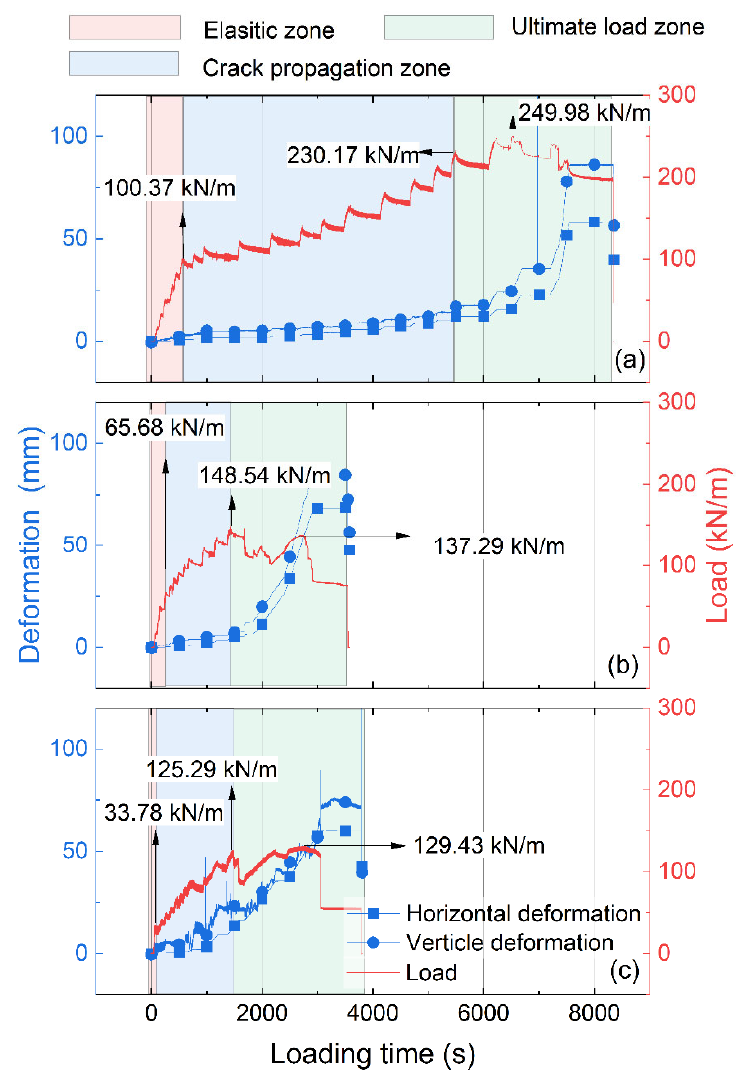
Figure 12. Evolution of force and displacement of 2000–mm concrete pipes when performing a three-edge bearing test, where ( a – c ) represent the pipe without wall loss, with 15–mm, and with 25–mm wall loss, respectively.